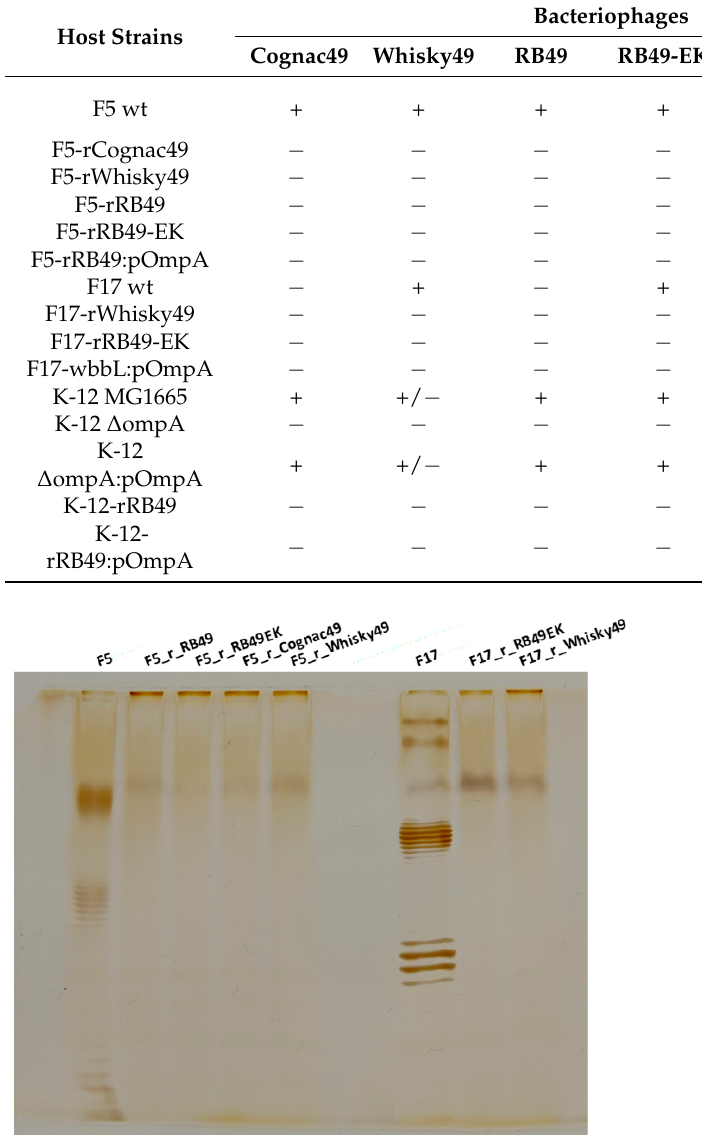
Figure 3. LPS profiles (SDS-PAGE) of the derivatives of the strains F5 and F17 selected for resistance to the phages RB49, RB49EK, Cognac49 and Whisky49.